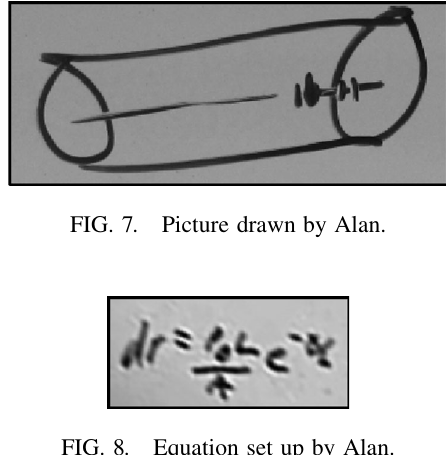
FIG. 11. Expression for total